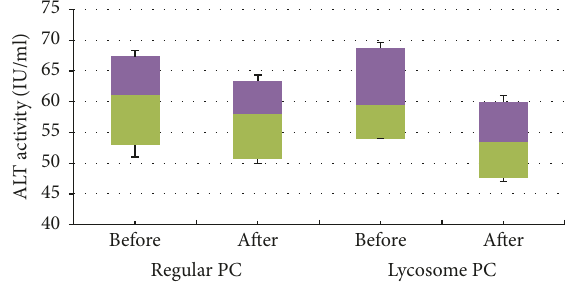
Figure 2: Box-and-whisker analysis of serum ALT activity . The patients were screened, enrolled, randomized, and treated with regular (PC) or lycosome (PC-Lycosome) formulations of phos- phatidylcholine (PC) for 2 months as described in Materials and Methods. Median values with confidence intervals for serum ALT activity at time “0” and the end point of the study are shown above.